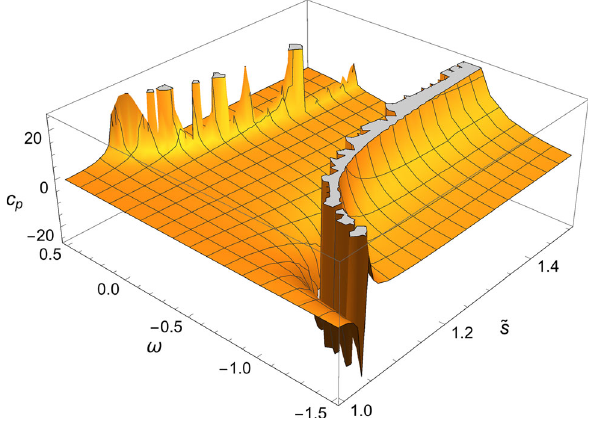
Fig. 9 c p − ˜ s − ω diagram, assuming p =